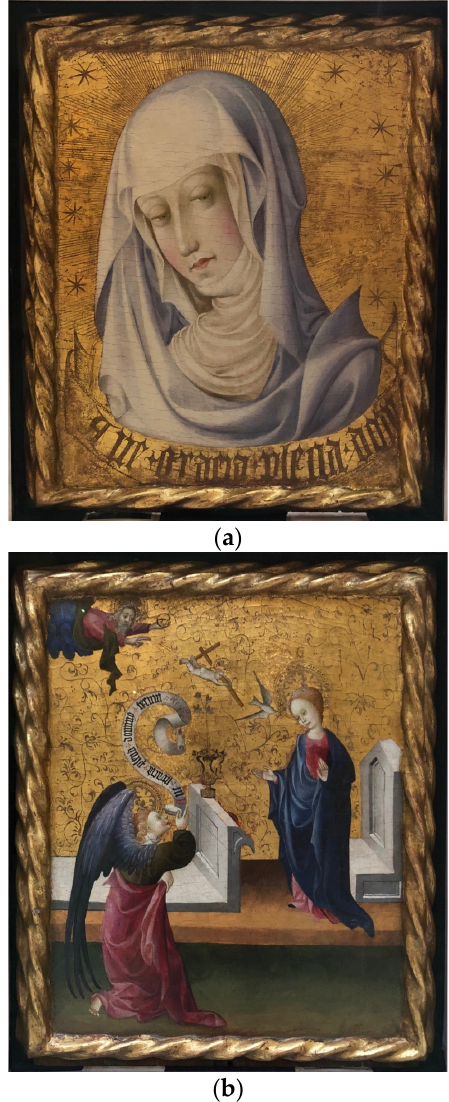
Figure 7. Face of Mary and the Annunciation, Gonçal Peris Sarrià, ca. 1403–1410, Museu de Belles Arts of Valencia. ( a ) Face of Mary; ( b ) Annunciation. © Museu de Belles Arts of Valencia